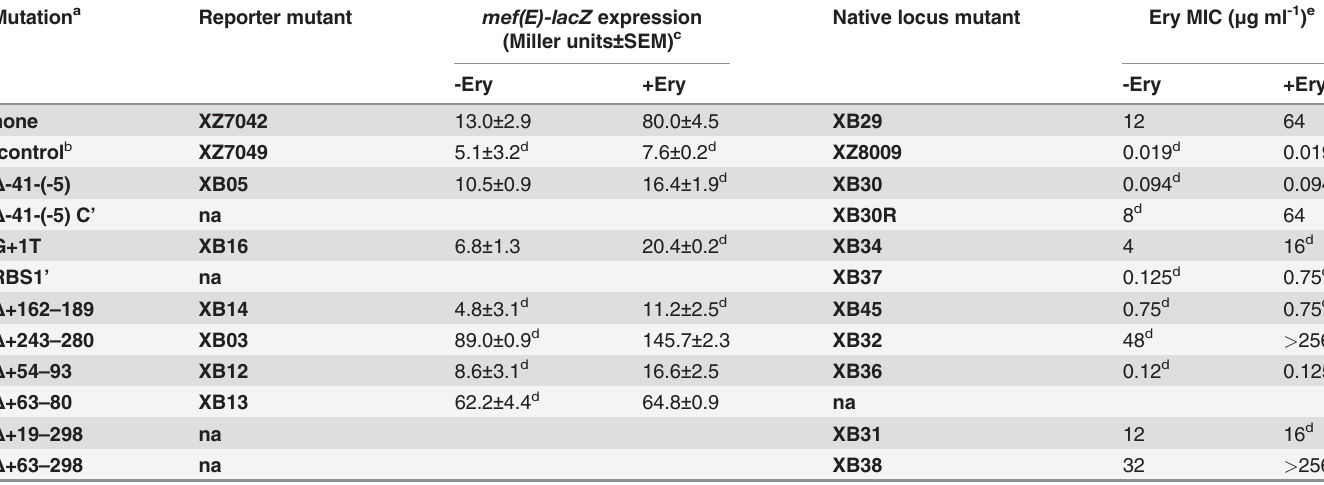
Table 2. In fl uence of regulatory mutations on resistance to erythromycin and expression of mef(E) . Mutation